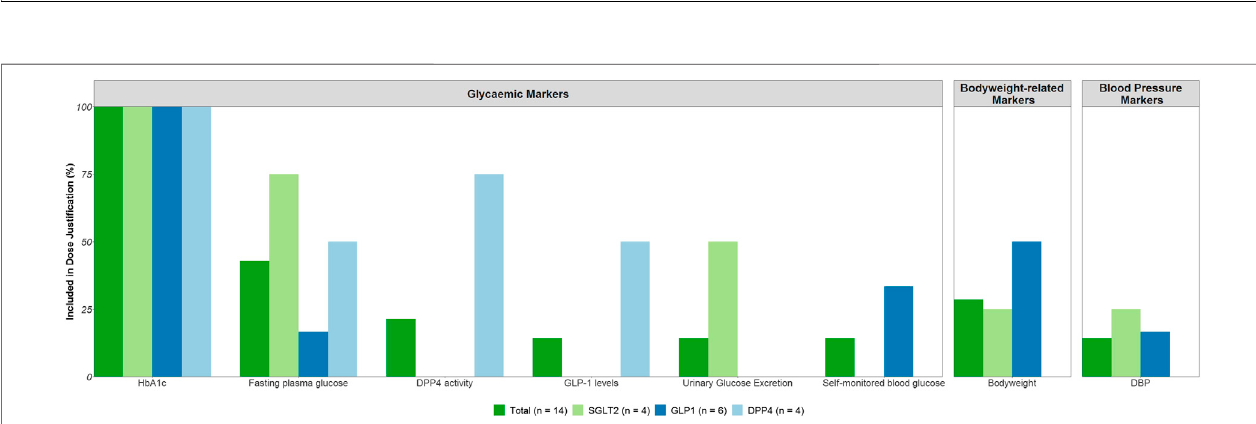
FIGURE3| On-andOff-targeteffects included inthejusti fi cationofthephase3doserange. Abbreviations:Diastolicbloodpressure(DBP),dipeptidylpeptidase-4 (DPP4), fasting plasma glucose (FPG), glucagon-like peptide-1 (GLP1), glycated hemoglobin (HbA1c), sodium-glucose co-transporters -2 (SGLT2).